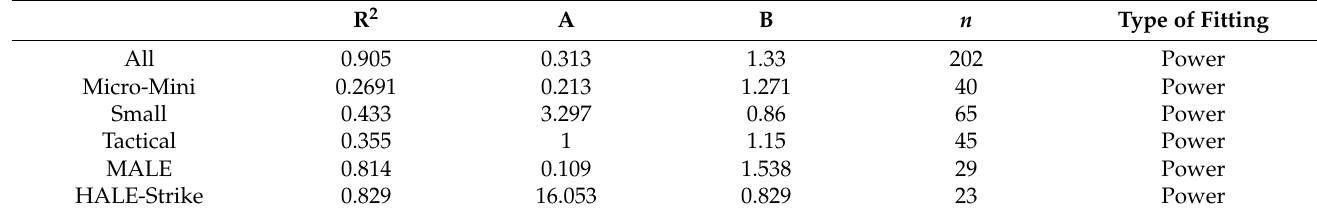
Figure 18. W p · E as a function of GTOW with respect to NATO categories. Table 8. Statistical data regarding the trend fitting for the W p · E vs. GTOW